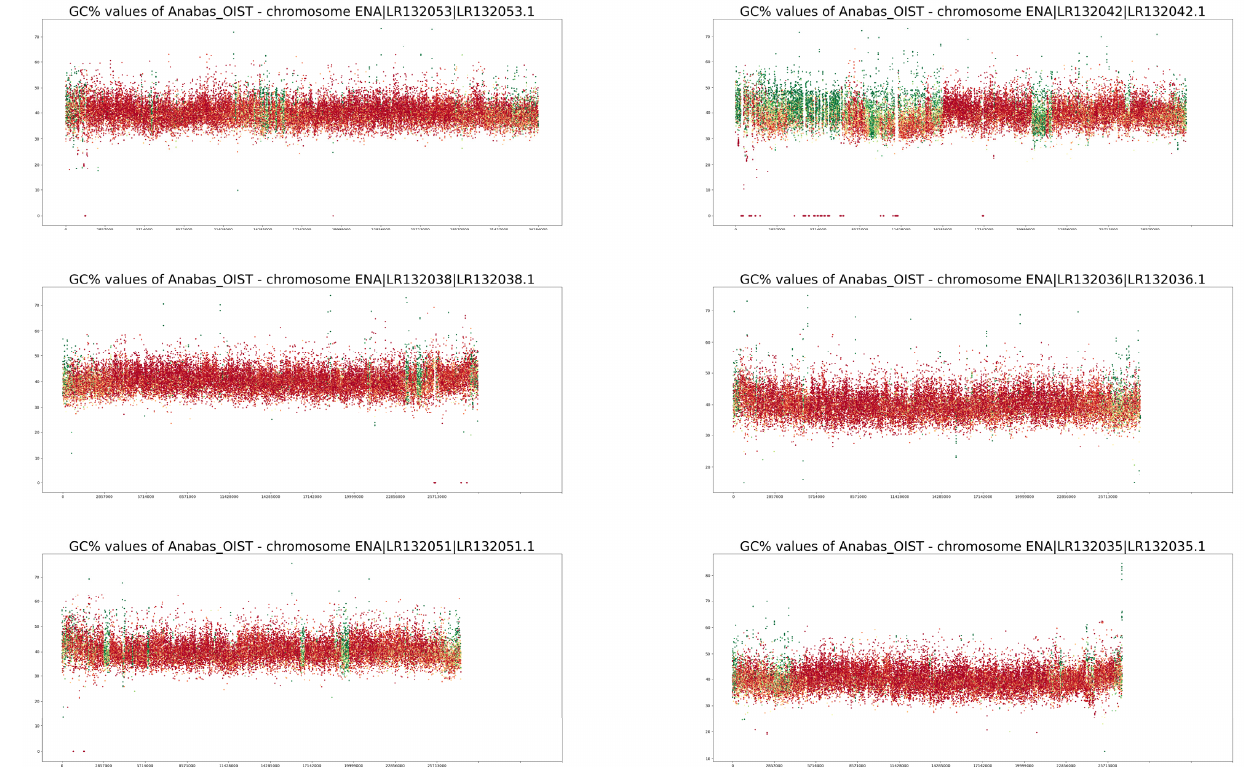
5 Figure A2. Cont